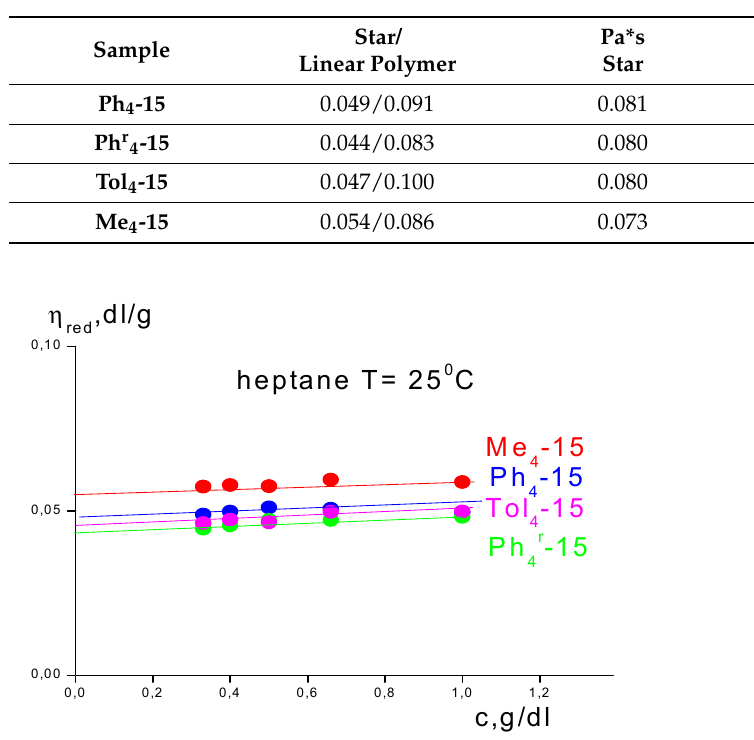
Table 3. Rheological properties of SSP in solution and in bulk.